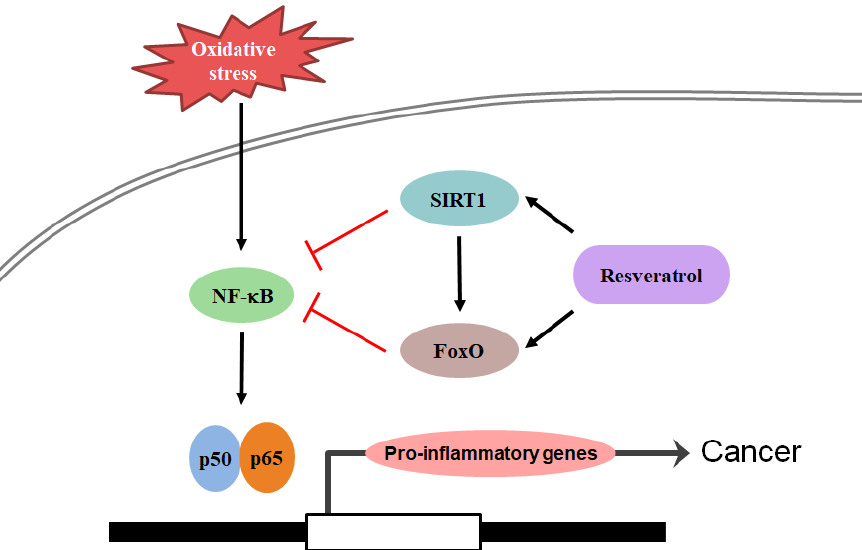
Figure 1. Molecular mechanism of cancer and its intervention by resveratrol. Proinflammatory molecules induced by oxidative stress causes chronic inflammation leading to cancer. Upregulation of NF- κ B leads to the expression of inflammatory mediators, COX-2, iNOS, cytokines, and chemokines. All these molecules were modulated by